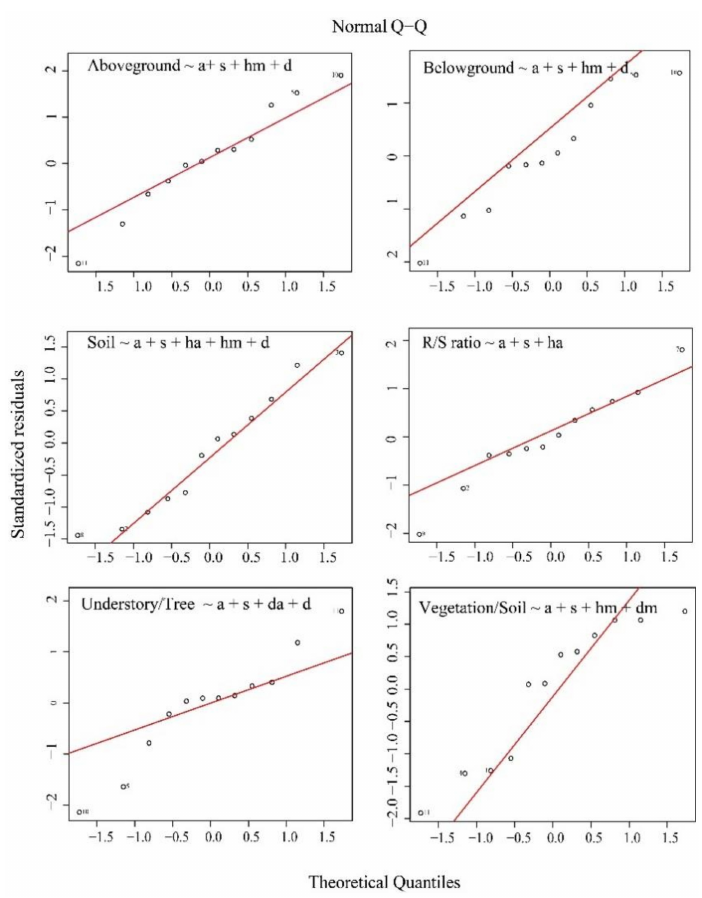
Figure A1. The diagnostics plots of multiple regression